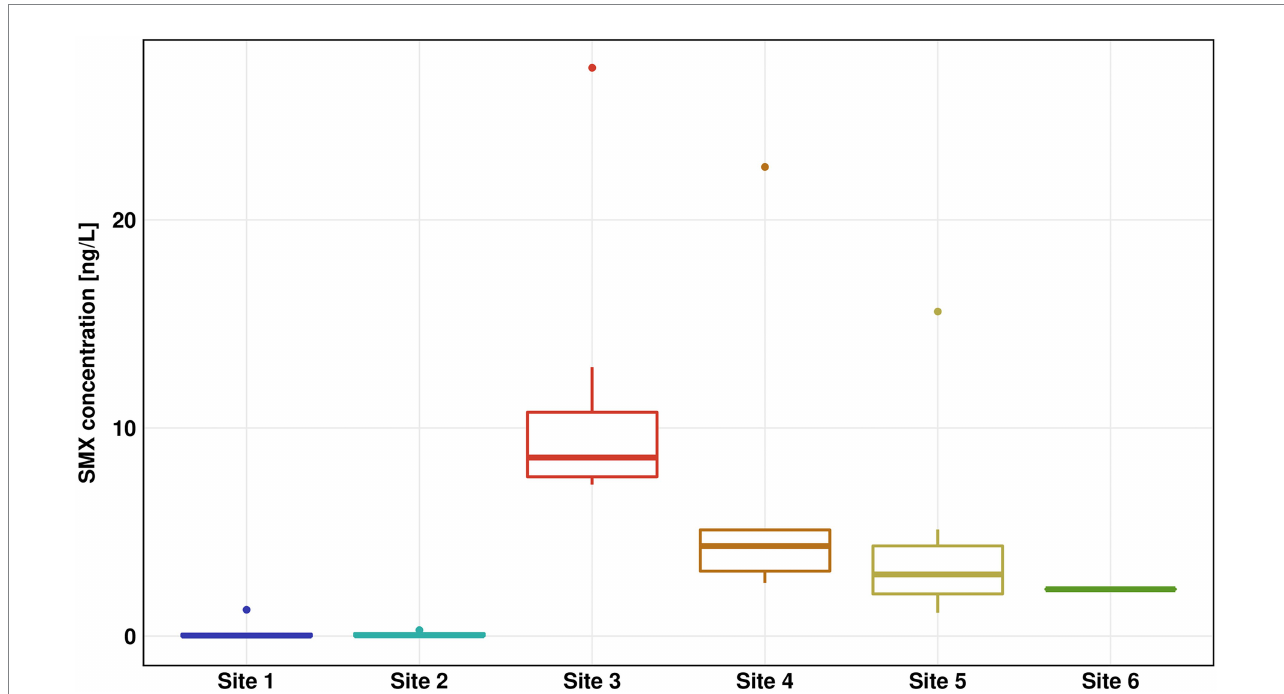
FIGURE 2 Sulfamethoxazole (SMX) concentration for all six sites measured by high performance liquid chromatography–mass spectrometry (HPLC-MS)/mass spectrometry (MS). The results of seven replicates are shown using box-whiskers-plots with the median represented by a horizontal line. Colors are representing the different sites (Site 1 in blue, Site 2 in turquoise, Site 3 in red, Site 4 in orange, Site 5 in yellow, and Site 6 in